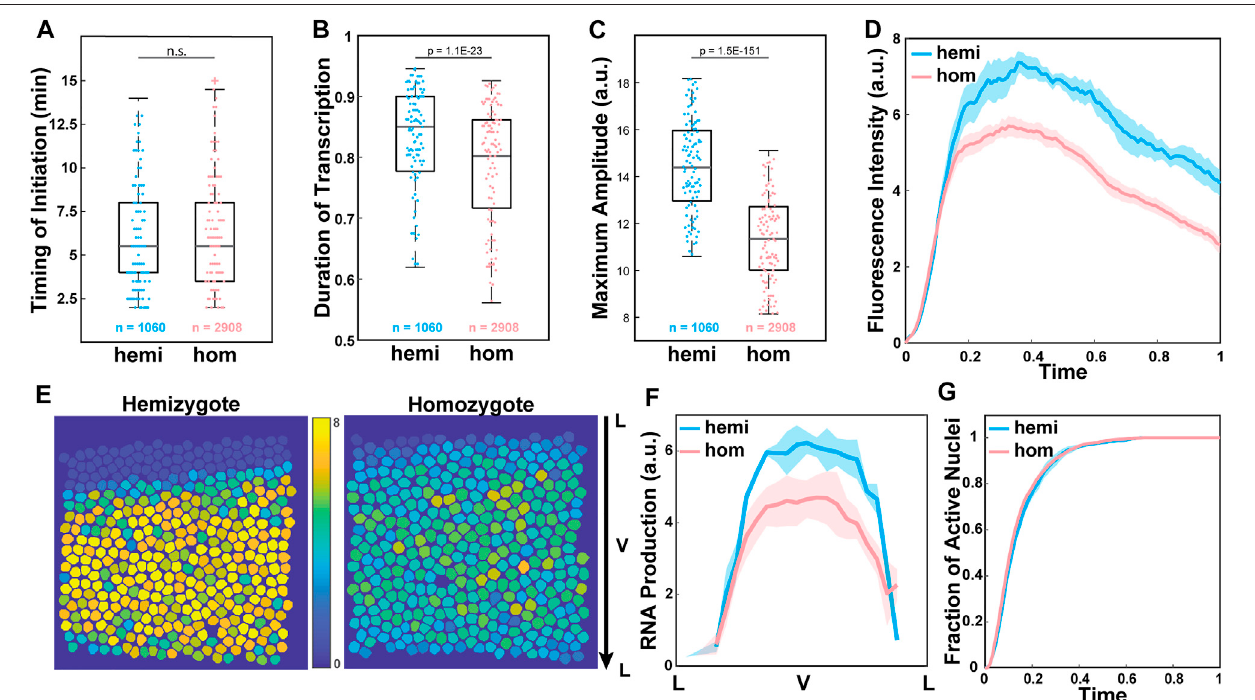
FIGURE 2 | Low transcriptional amplitude caused reduced RNA output in the homozygous alleles. (A) Boxplot of the timing of transcription initiation for hemizygotes (hemi) and homozygotes (hom) expressing snaSE > yellow . For both genotypes, transcription was initiated about 6 min after the onset of NC14. n indicates the number of analyzed nuclei from 4 and 10 biologically replicate embryos of each genotype, respectively. (B) Boxplot of the duration of active snaSE > MS2-yellow transcription in NC14, where total duration is scaled to one. The hemizygous and the homozygous alleles spend comparable time in the active transcription state. (C) Boxplot of the average amplitude of MS2-yellow fl uorescent intensity in snaSE > yellow hemizygotes and homozygotes. The amplitude in homozygous embryos is about 20% lower than the one in hemizygous embryos. (D) Average transcriptional trajectories of active nuclei from hemizygous (blue) and homozygous (red) embryos. Themaindifferencebetweenthegenotypesistheaverageamplitude. (E) HeatmapsofarepresentativesnaSE > yellow hemizygous(left)andhomozygous(right)embryo showing the accumulated RNA production of the MS2-yellow allele in NC14 of all nuclei within the sna expression domain. The RNA production is reduced throughout the ventral side of the homozygous embryo. The snapshot shows a ventral view of an embryo. (F) Average RNA production of one allele in hemizygotes (blue) and homozygotes(red)expressingthesnaSE > MS2-yellow reportergenealongthedorsoventralaxisofanembryo.TheRNAproductionisreducedthroughoutthedomainin homozygotes yet the sna expression boundary is not narrowed. (G) Plot of the cumulative fraction of active nuclei over the duration of NC14 in hemizygotes (blue) and homozygotes (red). Both genotypes produce RNAs with similar kinetics of transcriptional activation. The number of analyzed nuclei is the same as the one shown in Figure 1E . For boxplots in (A – C), the scatter points indicate values from 200 randomly selected nuclei used in the analysis. The box indicates the 25%, 50% and 75% quantile,andthewhiskersextendtothe10thandthe90thpercentileofeachdistribution.Theerrorbarin(D),(F)and(G)representstheStandardErrorofMean(SEM)for 4 and 10 biologically replicate embryos for hemizygous and homozygous snaSE > yellow embryos, respectively.